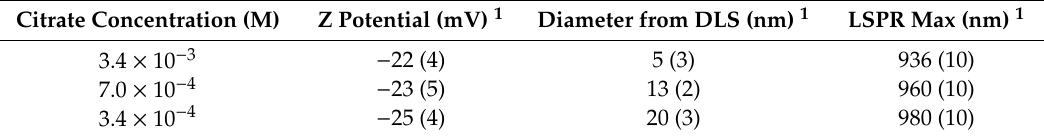
Table 1. Characterization parameter of CuS NP prepared under di ff erent citrate concentrations.